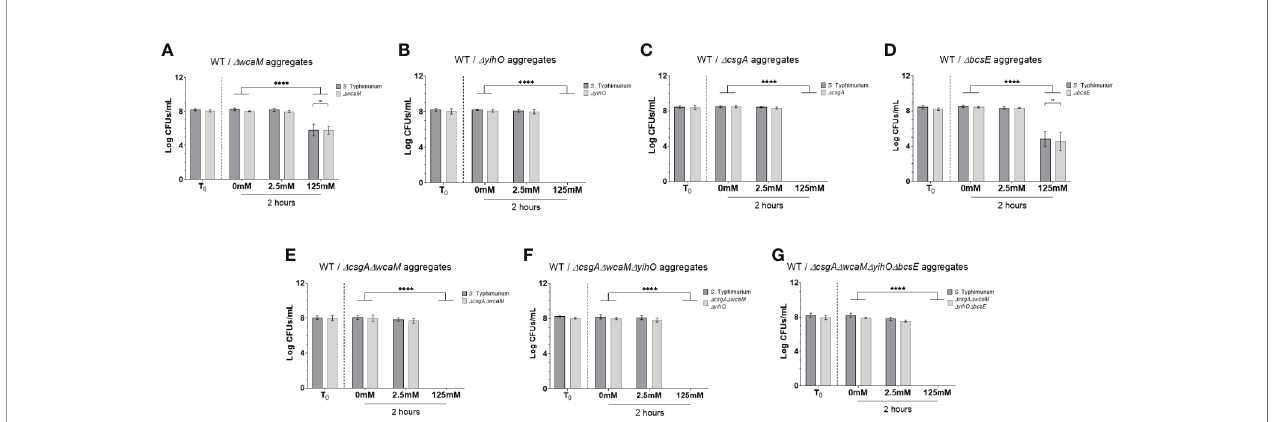
FIGURE 2 | Tolerance of co-cultured WT S. Typhimurium and EPS mutant bio fi lms to H 2 O 2 . (A – G) Bio fi lms were cultured with a 1:1 ratio of WT S. Typhimurium and an EPS mutant. Aggregates of these bio fi lms were challenged with H 2 O 2 at a known tolerable dose (2.5 mM) and a challenge dose (125 mM) then enumerated on differential antibiotic agar. Signi fi cant differences were determined by two-way ANOVA and Tukey method for multiple comparison correction (****p < 0.0001). No signi fi cant differences were observed between WT and mutant at any one H 2 O 2 concentration. Each experiment was conducted in triplicate and the data represents the mean of three independent experiments. The error bars indicate